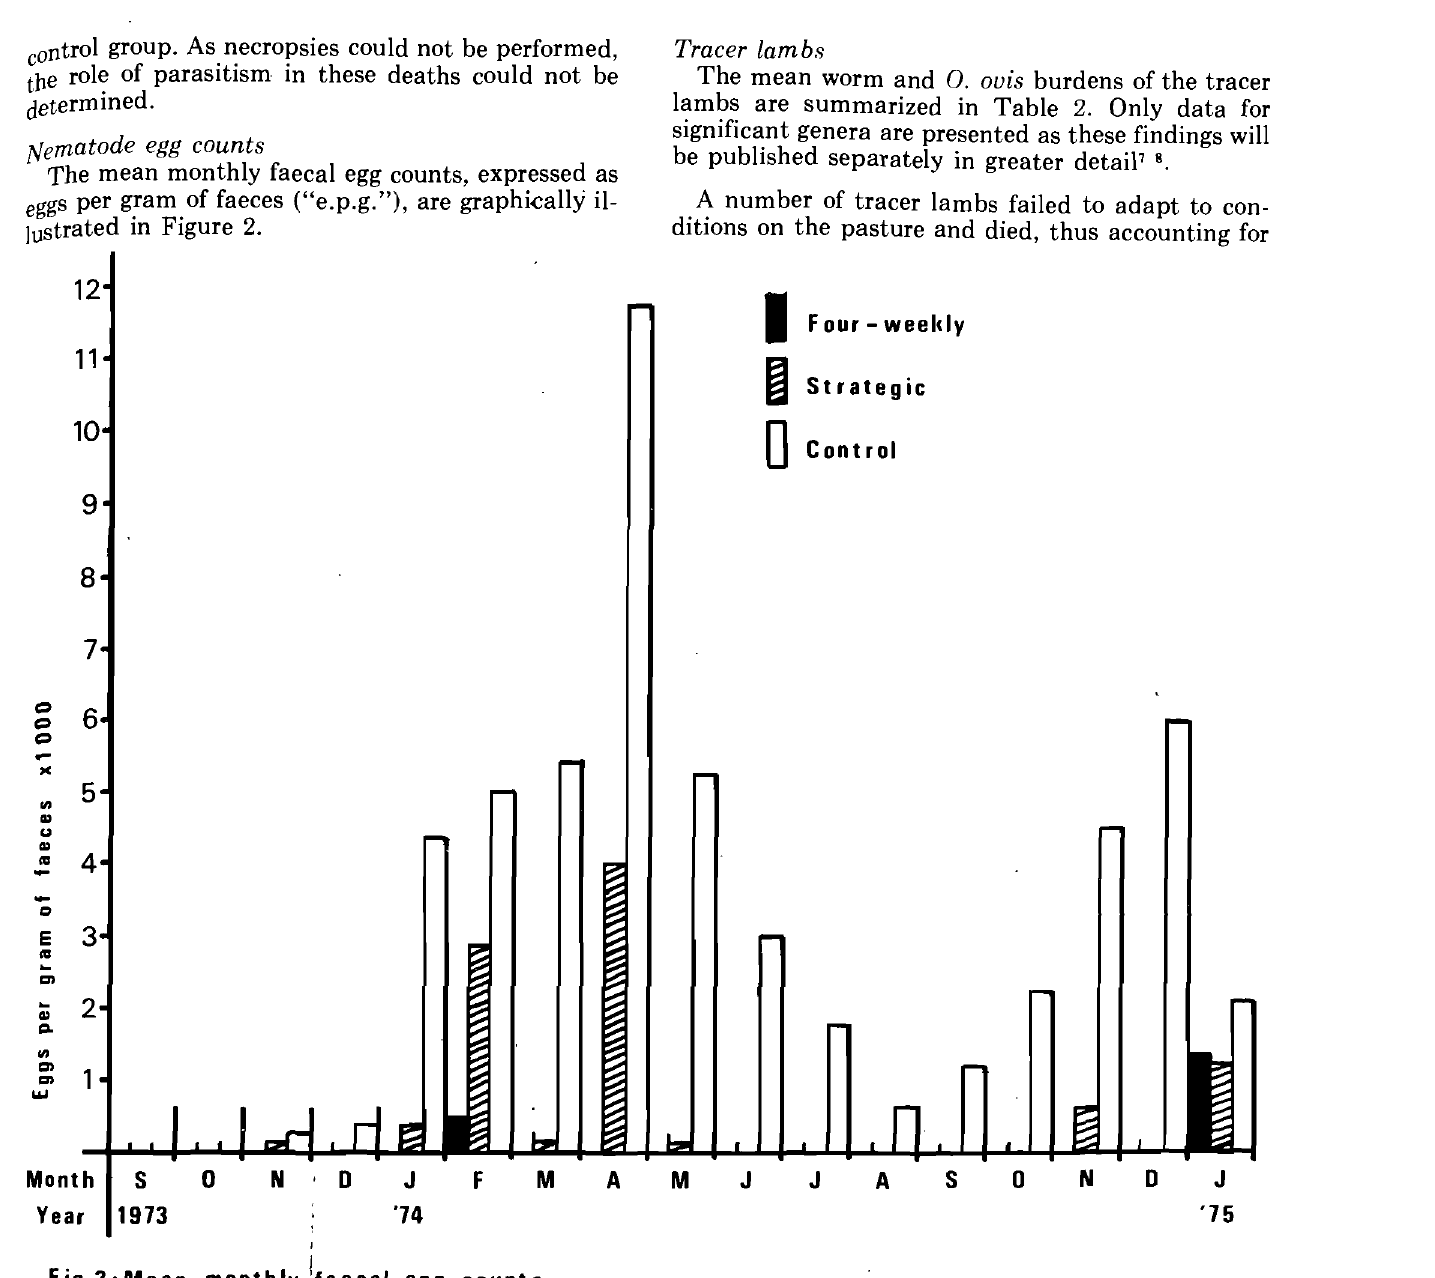
Fig.2:Mean monthly jfaecal egg counts Total faecal worm egg cpunts in the control group rose rapidly between December 1973 and January 1974 and reached a peak of 11 713 e.p.g. during April. Counts declined steadily thereafter to reach 584 e.p.g. during August, followed by' a consistent rise to peak